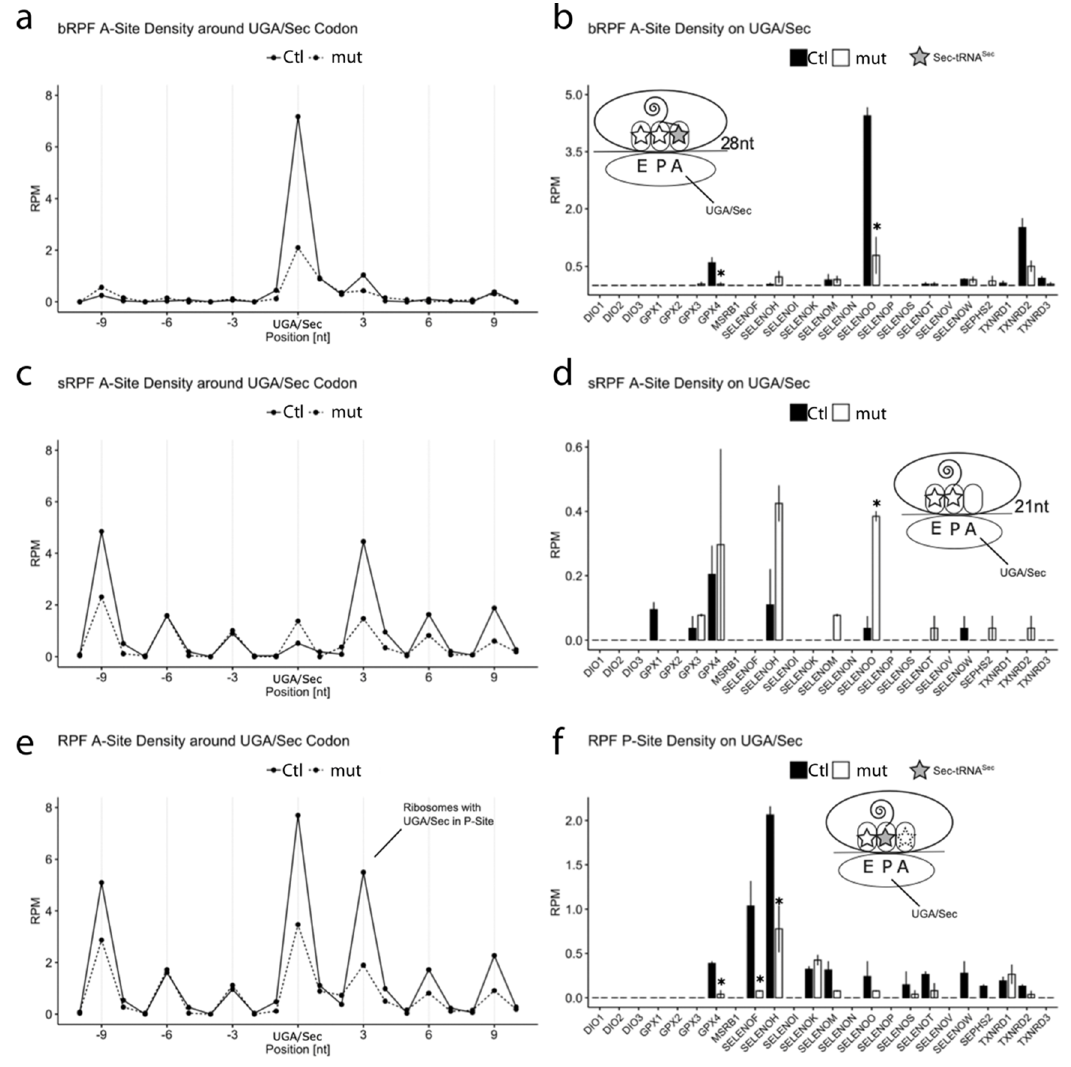
Figure 5. UGA codon occupancy in selenoproteins. RPF are centered on the UGA codon. An offset of 15 nt from the 5 ′ -end indicates that the UGA resides in the A-site. ( a ) Big RPF of 28 + 29 nucleotides length (bRPF, peak at 28 nucleotides) with the UGA/Sec in the A-site expressed as reads per million mapped reads (RPM) over all selenoproteins. ( b ) bRPF with the UGA/Sec in the A-Site expressed as RPM for single selenoproteins. ( c ) Small RPF of 20 + 21 nucleotides length (sRPF, peak 21 nucleotides) with the UGA/Sec in the A-site expressed as RPM over all selenoproteins. ( d ) sRPF with the UGA/Sec in the A-Site expressed as RPM for single selenoproteins. ( e ) RPF of both species combined with the UGA/Sec in the A-site expressed as RPM. ( f ) RPF of both species combined with the UGA/Sec in the P-Site expressed (pUGA) as RPM for single selenoproteins. An offset of 12 nt from the 5 ′ -end to the UGA indicates that the UGA has moved into the P-site (and the A-site occupies the +3 peak in the plot). Read-length distribution is shown in Figure A3. * p < 0.05